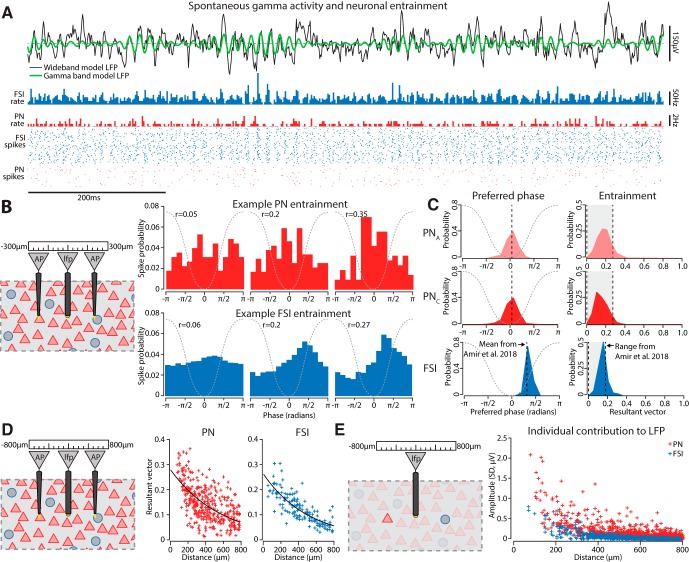
Spiking in the model was entrained to the gamma rhythm similarly to cells in vivo. A, Example trace of the calculated extracellular field from the center of the model and a raster plot of corresponding spiking from neurons within 300 µm (1026 PNs, 111 FSIs). Gamma bursts were evident, particularly following bandpass filtering around the peak gamma frequency. The group firing rates of FSIs and PNs exhibited modulations by the gamma rhythm, with the effect being more evident for FSIs. Spikes from individual neurons (each row is a different cell) did not spike on every gamma cycle. B, Left, Spiking from units (AP) within 300 µm of where the extracellular field was measured (LFP) were associated with the phase of the ongoing gamma oscillations. Right, Distribution of gamma phases when spikes occurred for three example PNs and FSIs, sorted by the strength of their phase locking. Dashed gray schematizes the corresponding gamma cycle. C, Left, The distribution of mean phases across each cell type. Both types of PNs preferentially spiked near the trough of the gamma oscillation, while FSIs spiked shortly thereafter during the ascending phase. Right, The distribution of phase-locking across cell types matched what we found for BL neurons in vivo. D, Left, Spiking was sampled from neurons spanning 800 µm away from the point where we measured the extracellular field, and neurons were sorted by their distance from that spot. Right, The farther a neuron was from the site were gamma was measured, the less phase-locked it was. Black lines are exponential fits. E, Left, The extracellular field arising from individual neurons was singled out to examine their distance-dependent contribution. Right, Neurons farther from the recording site contributed less to the extracellular field, and this fell off faster than the decay in the resultant vector in panel D.